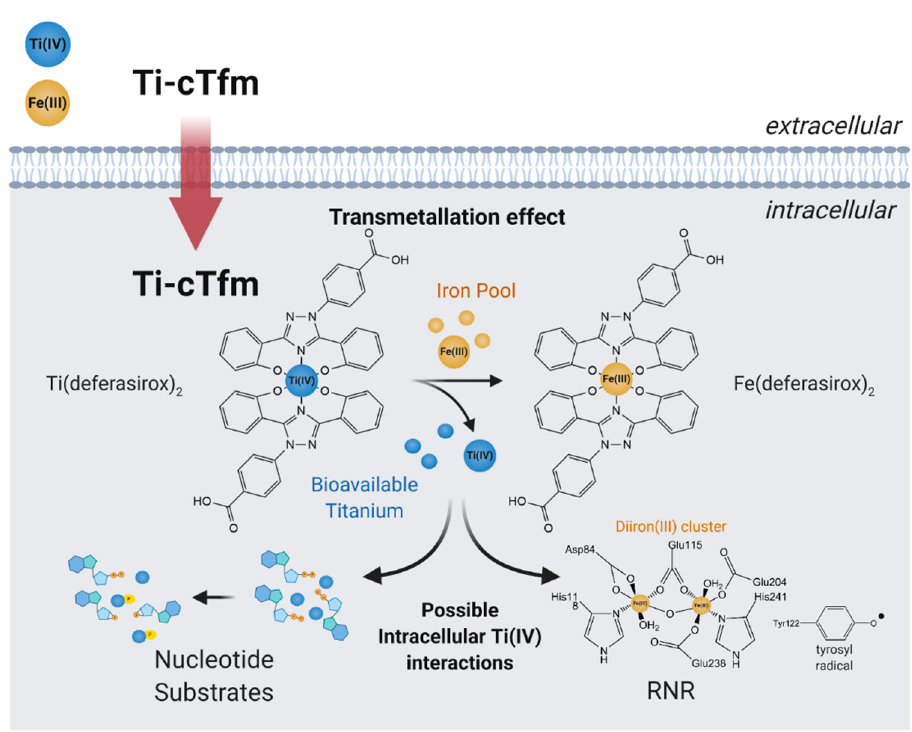
Figure 7. Proposed mechanism of action of the Titanium(IV)-chemical transferrin mimetics (Ti-cTfm).